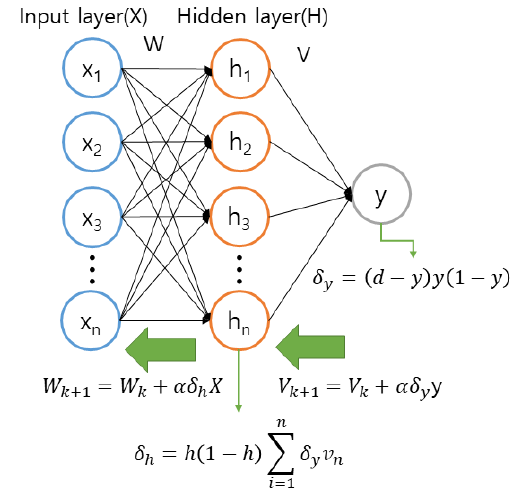
Figure 9. The one example of the six neural network models in the APDS.